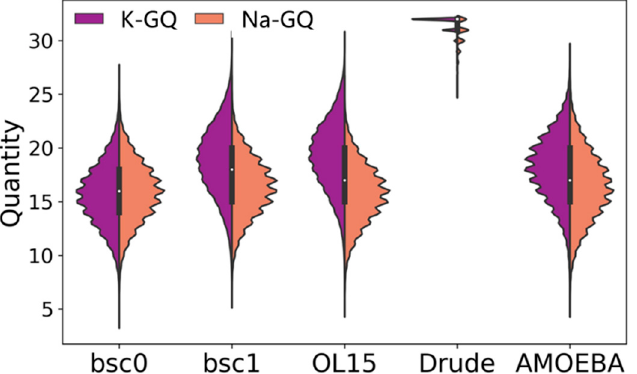
Figure 6. The distribution of total hydrogen bond number in the MD simulation for replication 1.